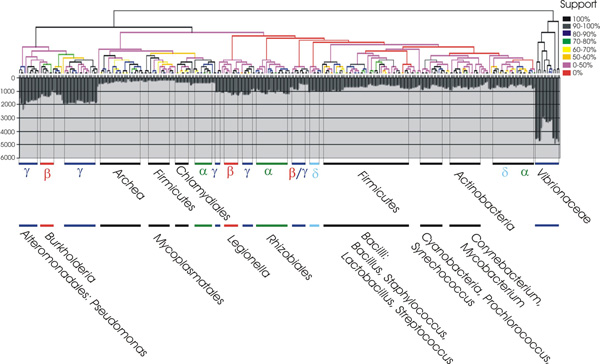
Hierarchical cluster analysis with bootstrap resampling method was performed on the complete set of organisms (columns of the phylogenetic profile matrix). The number of genes identified in each organism (with a similarity measure greater than zero) is reported as a gray histogram below the dendrogram. Organism taxonomies are highlighted with different colors: γ proteobacteria in blue, β proteobacteria in red, α proteobacteria in green, δ proteobacteria in light blue and others in black.